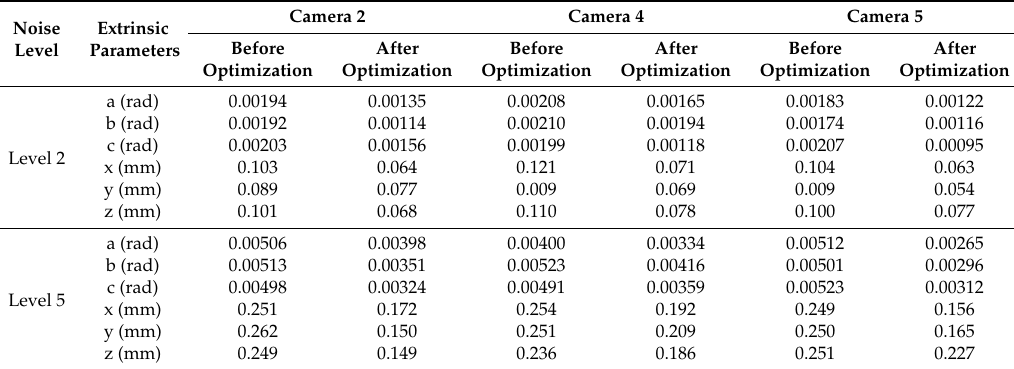
Table 2. The errors before and after optimization of the remaining cameras.